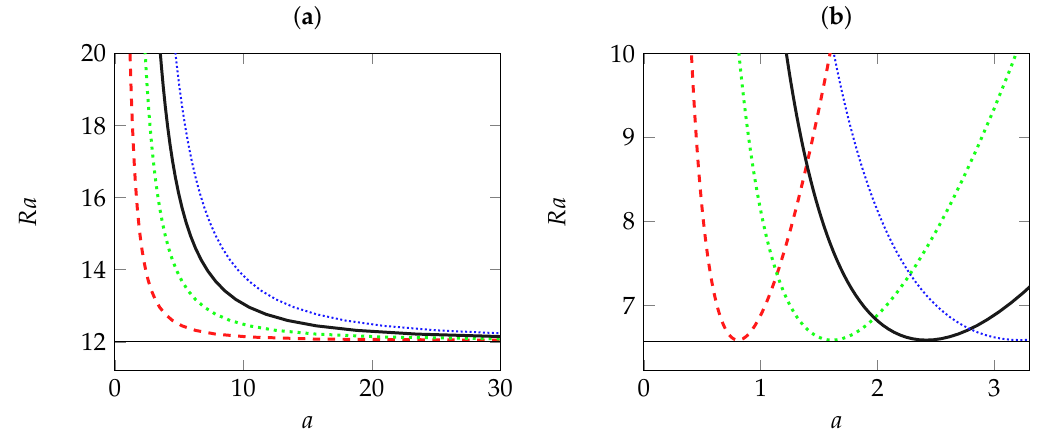
Figure 5. Critical Rayleigh number against the lateral aspect ratio with different numbers of rolls ( L = 1: red dashed curve; L = 2: green dotted curve; L = 3: black dash dotted curve; and L = 4: blue densely-dotted curve): ( a ) steady longitudinal rolls that exist independently of viscoelastic parameters; ( b ) oscillatory longitudinal rolls for Γ = 0.1 and λ 1 = 0.5. In both figures, the horizontal lines indicate the corresponding critical Rayleigh number for transverse rolls.